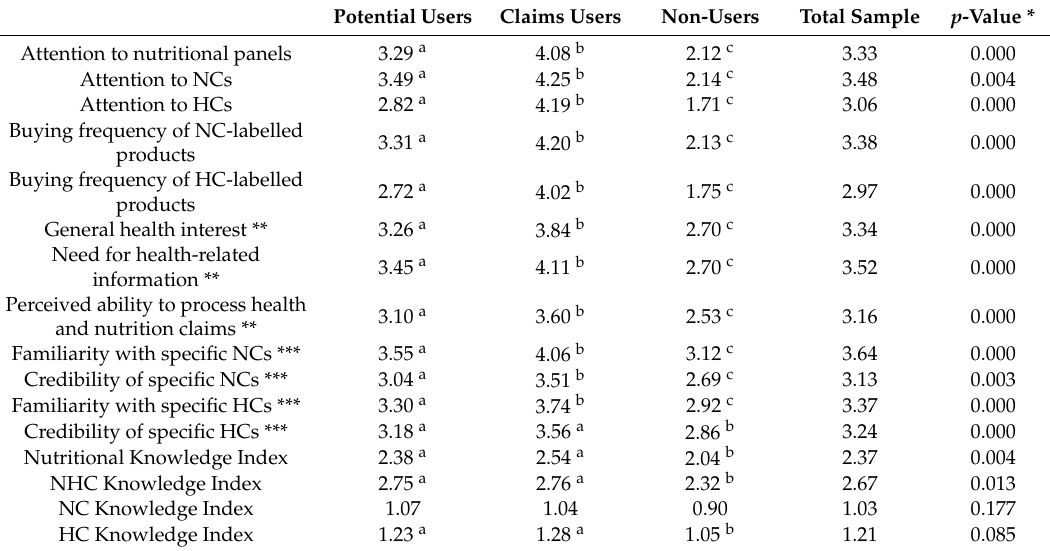
Table 4. Cluster profiling in terms of motivations, evaluation and knowledge of